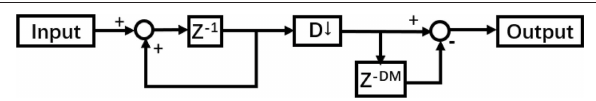
FIGURE 3 | Structure diagram of CIC decimation